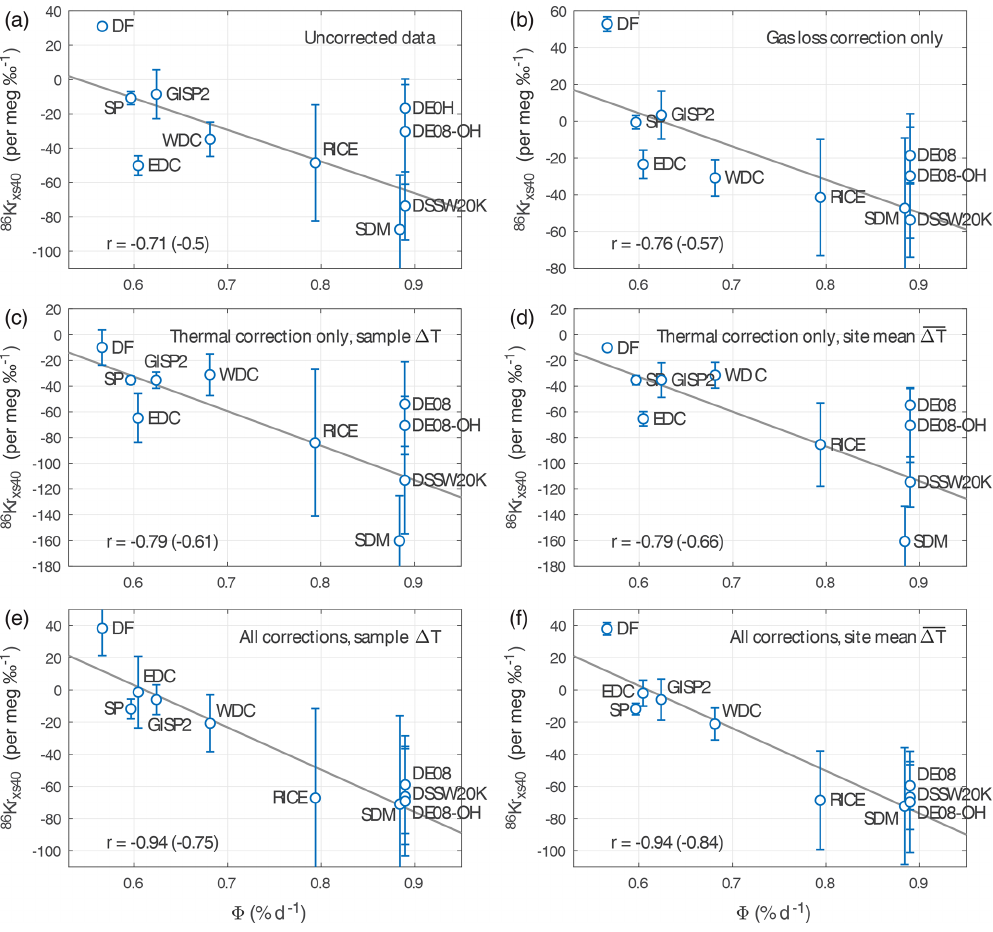
Figure A3. Influence of gas loss and thermal correction on the 86 Kr xs40 calibration. We plot 86 Kr xs40 as a function of (cid:56) (a) without any data corrections applied, (b) with only the gas loss correction applied ( ε 40 = − 0 . 008), (c) with only the thermal correction applied using individual sample (cid:49)T , (d) with only the thermal correction applied using individual site mean (cid:49)T , (e) with both gas loss and thermal corrections applied using individual sample (cid:49)T , and (f) with both gas loss and thermal corrections applied using site mean (cid:49)T . In each panel the correlations with (cid:56) are listed for the site average and individual sample with the latter in parentheses. For all correlations p < 0 .